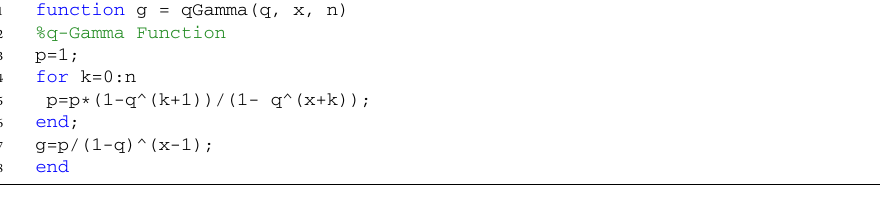
Algorithm 2 The proposed method for calculated Γ q ( x )